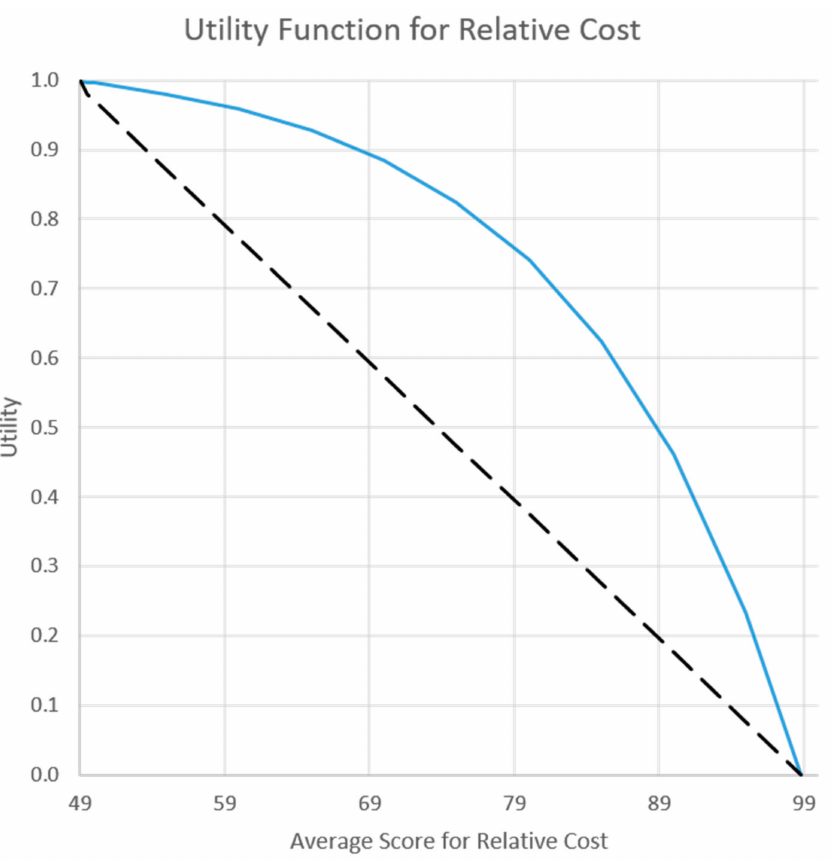
Figure 3. Utility functions for cost showing risk neutral (dashed line) and risk averse (solid line) decision